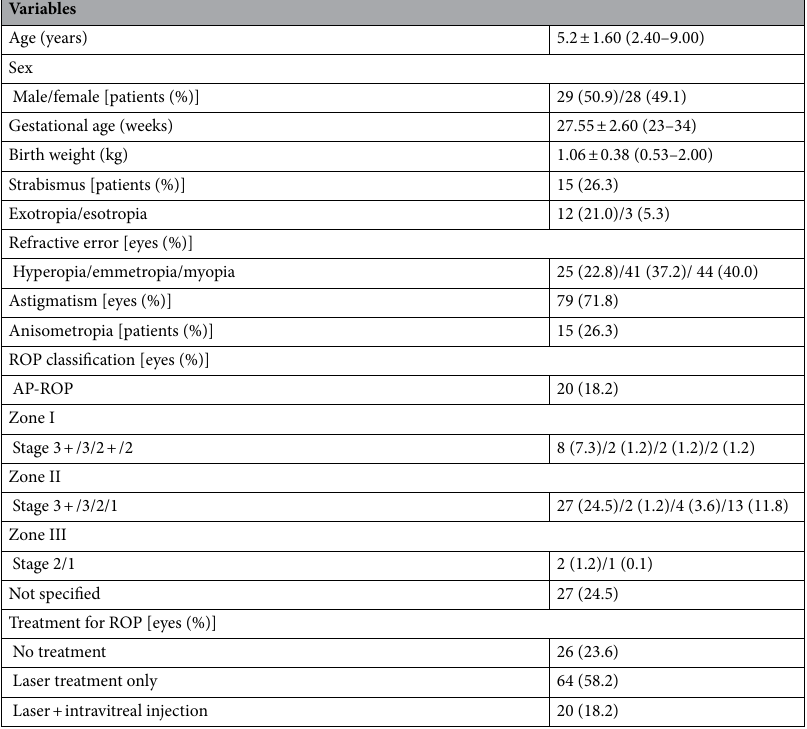
Table 1. Demographic characteristics of the enrolled subjects (N = 57, 110 eyes). Values are presented as numbers (%) or mean ± standard deviation (range). Myopia, spherical equivalent (SE) ≤ − 1.0 D; hyperopia, SE ≥ + 1.5D; astigmatism, cylindrical error (Cyl) ≤ -1.0 D without reference to the axis; anisometropia, SE difference between the two eyes > 2 D. ROP = retinopathy of prematurity; AP-ROP = Aggressive Posterior ROP : located in posterior retina (Zone I or posterior Zone II), prominence of plus disease (in all four quadrants), and the ill-defined nature of the retinopathy. Stage1 = Demarcation line; Stage2 = Ridge; Stage3 = Ridge with extraretinal fibrovascular proliferation. Plus sign ( +) = vascular changes with marked increasing dilation of posterior vein and tortuosity of the